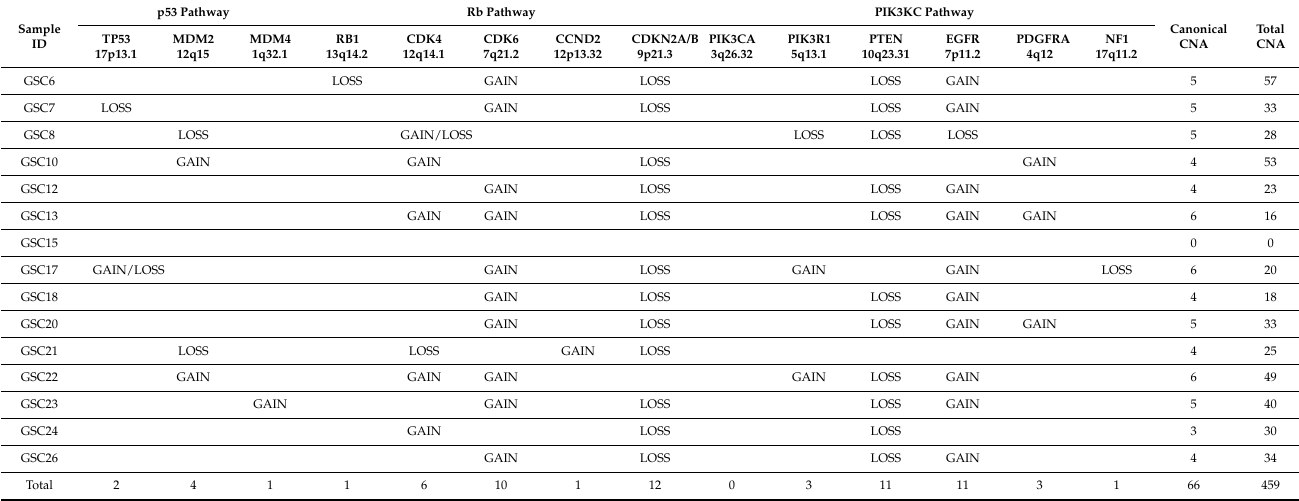
Table 3. Summary of copy number alterations affecting the three main canonical pathways altered in high-grade gliomas. The analysis was conducted on patient-derived primary glioma stem cell cultures (GSCs). The canonical CNAs load (Canonical CNA) and the total burden of imbalances (Total CNA) per sample were also